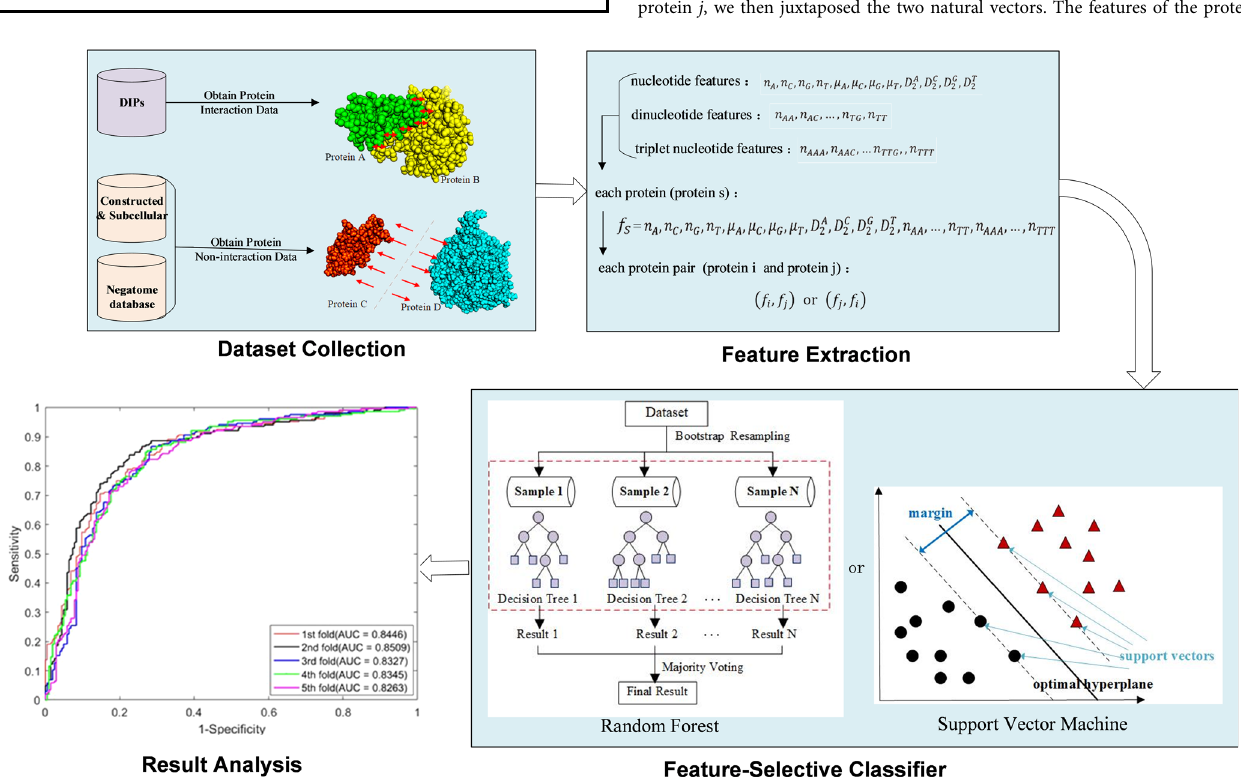
Fig. 3 Work fl ow of our computational pipeline to predict protein-protein interaction and non-interaction. It describes the whole research process, including dataset collection, feature extraction, feature-selective classi fi er and result analysis.